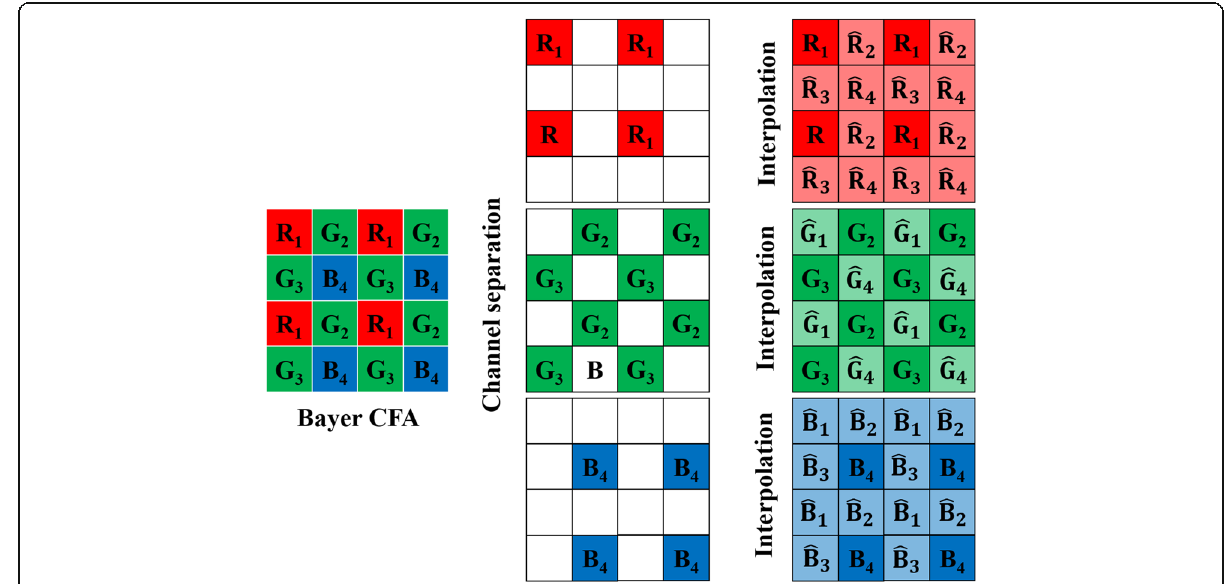
Fig. 2 Typical demosaicing process for Bayer CFA